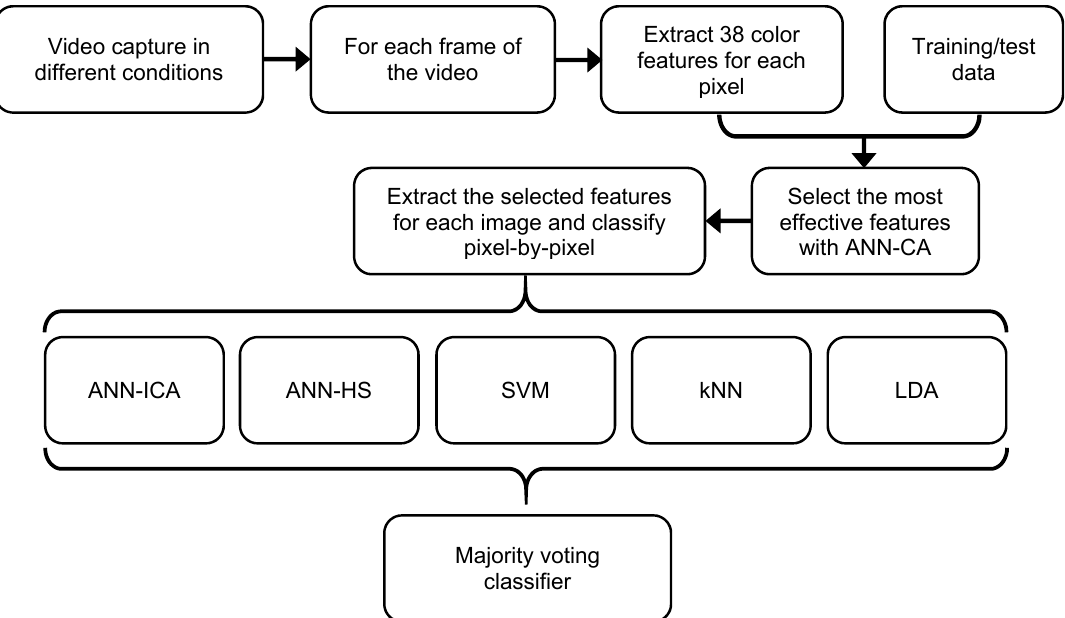
Figure 1. Diagram of the steps of the original approach for plum fruits segmentation.